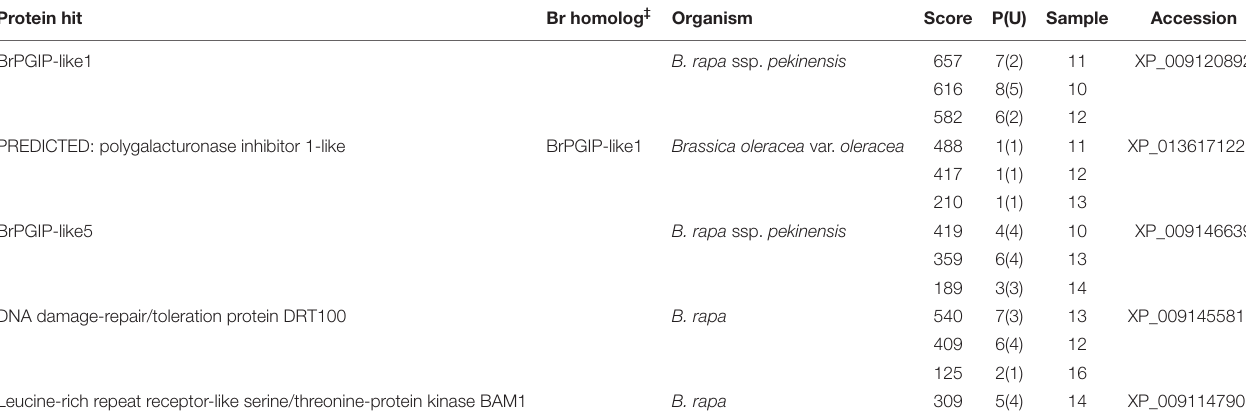
TABLE 2 | Extracellular LRR protein hits from a pull-down assay of PCO_GH28-3 with B. rapa ssp. pekinensis CWPs. Protein